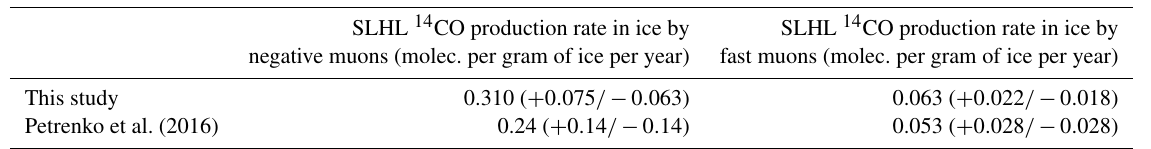
Table 3. 14 CO-specific surface production rates in ice from the two muon mechanisms normalized to the SLHL (sea level high latitude) site using the Lifton et al. (2014) LSDn scaling. All errors shown represent the 95% confidence interval. SLHL 14 CO production rate in ice by SLHL 14 CO production rate in ice by negative muons (molec. per gram of ice per